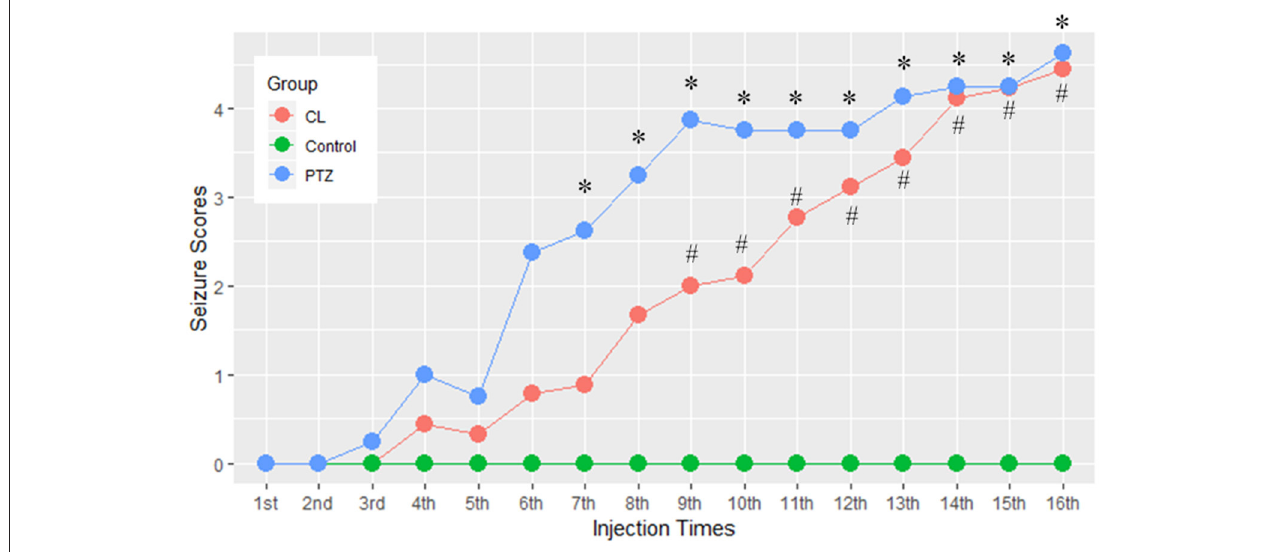
FIGURE 2 | Time spent in the central area (s) in the open field tests. Both the CL and PTZ groups showed greater time spent in the central area. * P < 0.05.